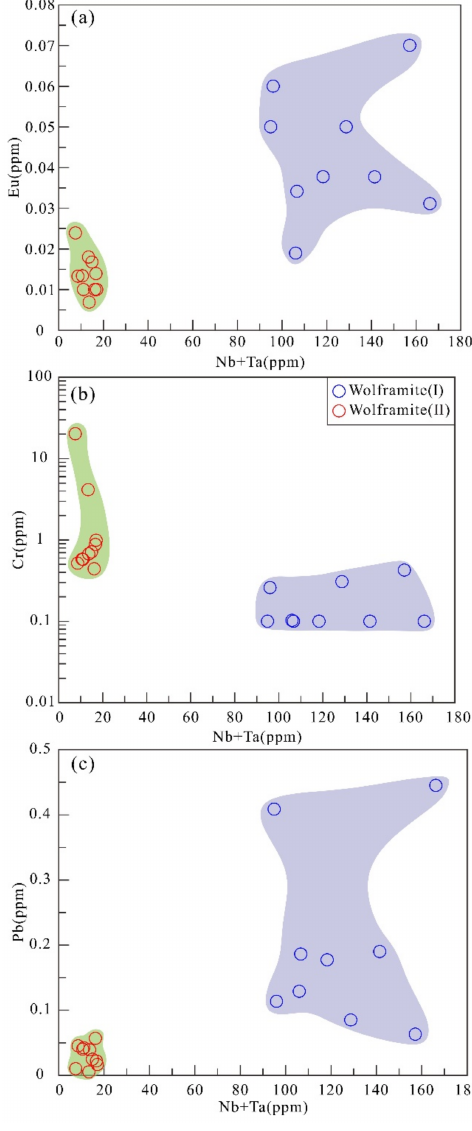
Figure 19. ( a ) Plot of Eu versus (Nb + Ta) of wolframite. ( b ) Plot of Cr versus (Nb + Ta) of wolframite. ( c ) Plot of Pb versus (Nb + Ta) of